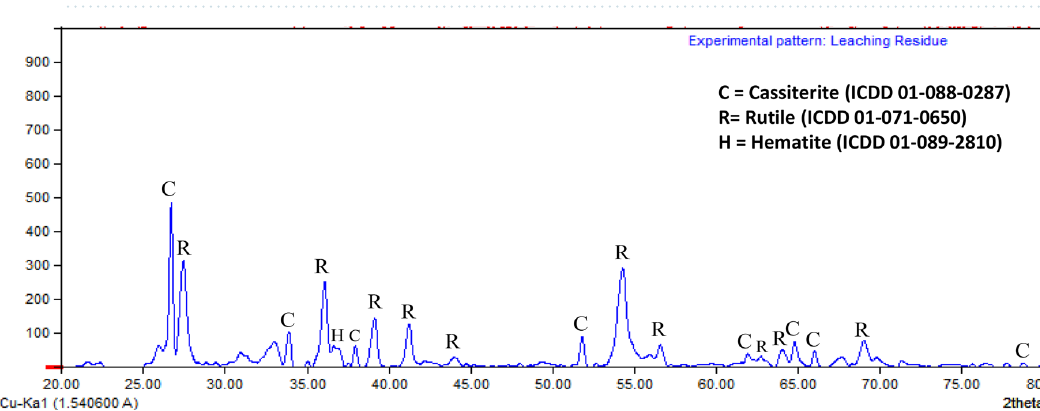
Figure 9. XRD patterns of the leaching